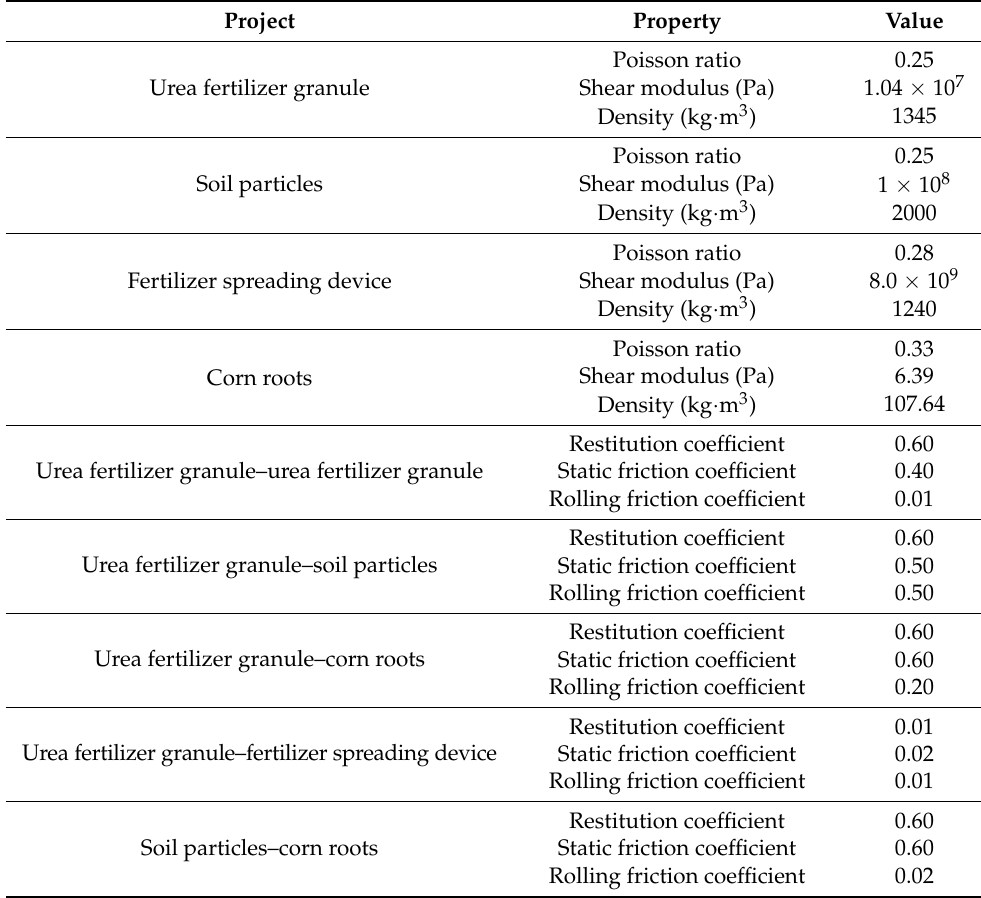
Table 1. Global variable parameter